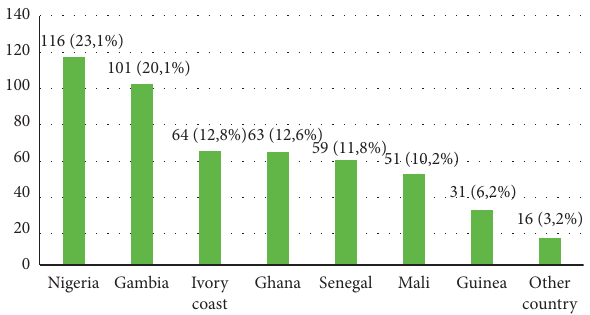
Figure 3: Migrants’ country of origin (total TB infection: 501). Figure 4: Prevalence of TB infection (total number: